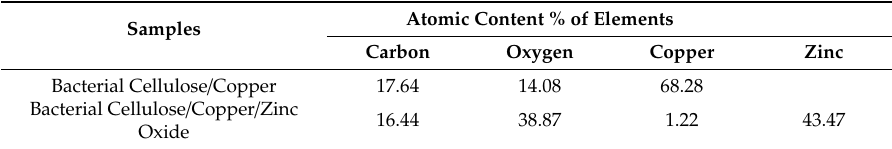
Table 1. Atomic content percentages of different elements in nanocomposites.